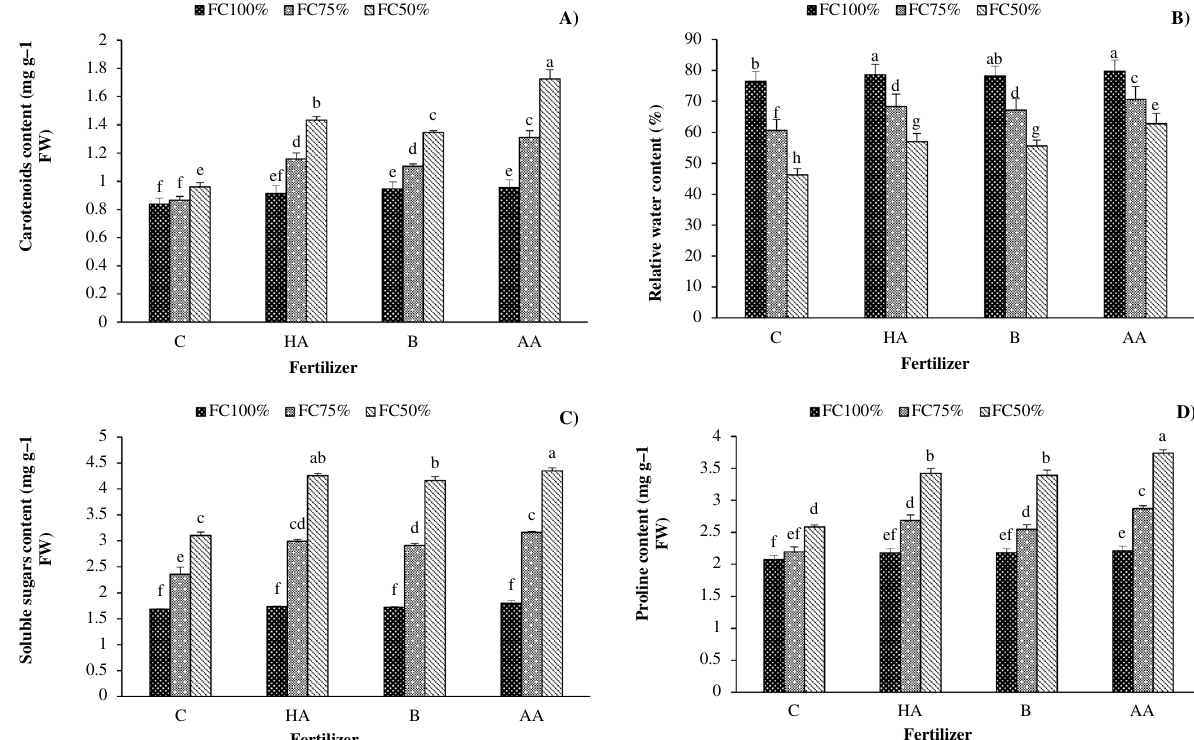
Figure 3. Interaction effects of irrigation regime and biofertilizer application on ( A ) carotenoids content, ( B ) relative water content, ( C ) soluble sugars content, and ( D ) proline content in savory. C control, HA humic acid, B bacterial, AA amino acid. Different lower-case letters above bars indicate significant differences at P <